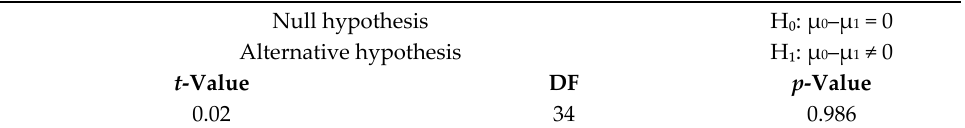
Figure 12. Age t -tests.